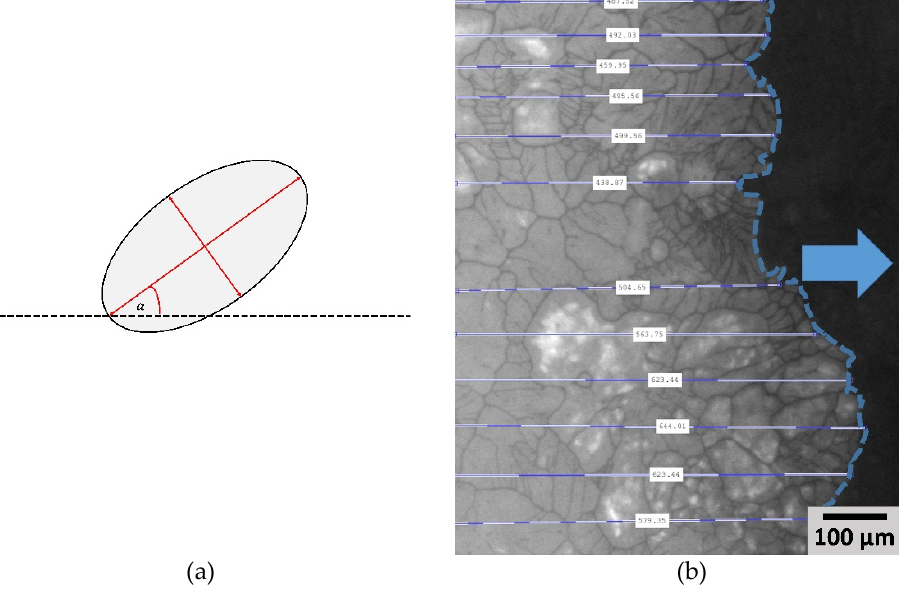
Figure 3. Illustration of ( a ) measuring the pore orientation and aspect ratio and ( b ) for calculating sublimation front velocity.